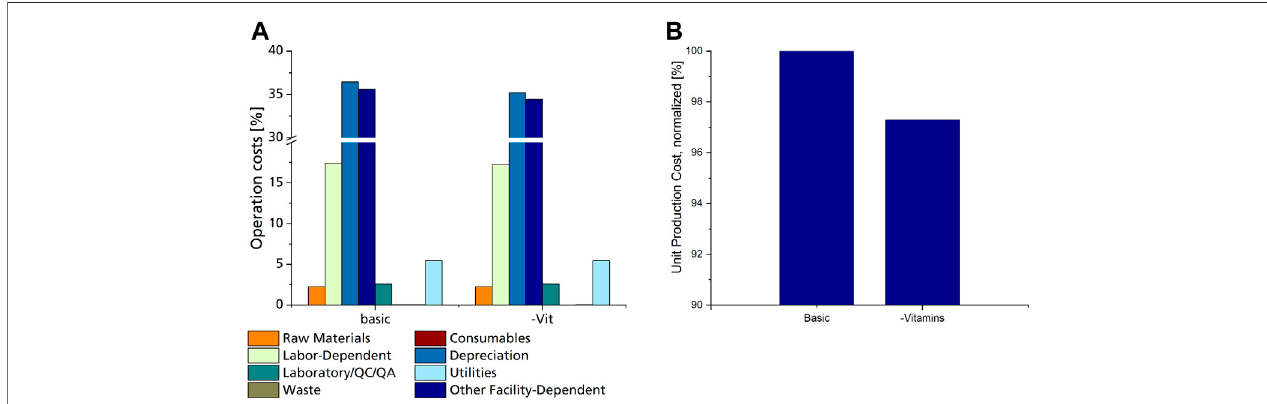
FIGURE 5 | (A) Distribution of operation costs for the basic scenario and scenario #13 utilizing a fermentation medium without vitamins, as % of overall operation costs. (B) Normalized UPC of the basic scenario with mineral salt medium, including vitamins, compared to scenario 13 utilizing the same mineral salt medium without